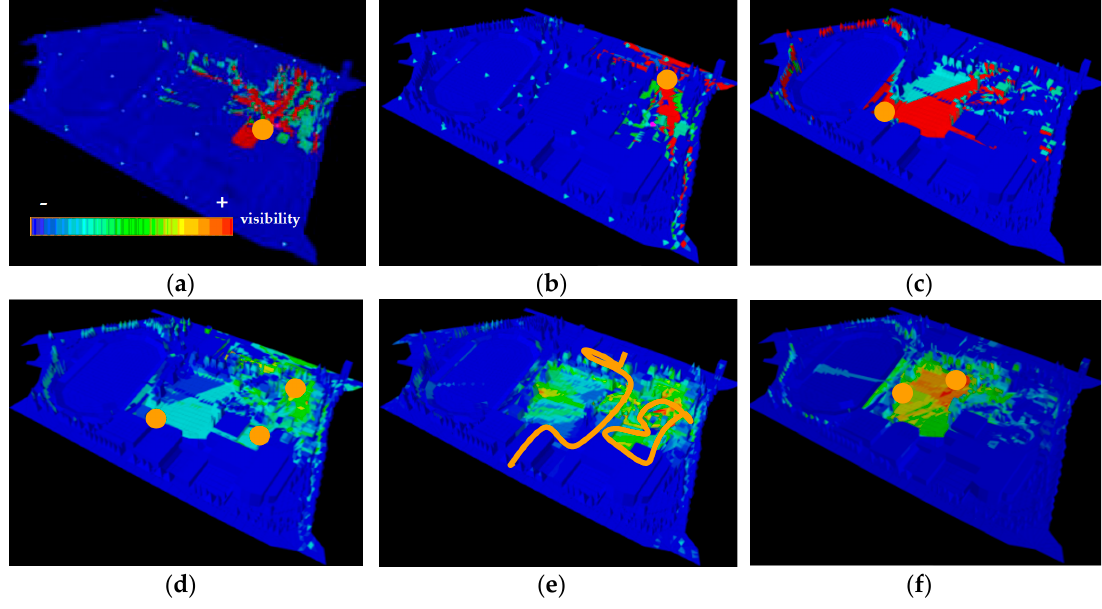
Figure 6. Visibility analysis of particular spaces and definition of differentiated spaces. ( a ) Isovist from the walkway; ( b ) isovist from the gazebo; ( c ) isovist from the bar; ( d ) visibility from the three referential points: walkway, gazebo, and bar; ( e ) visibility from a meandering path in the park; ( f ) visibility from the informal stands [17] (p. 224).